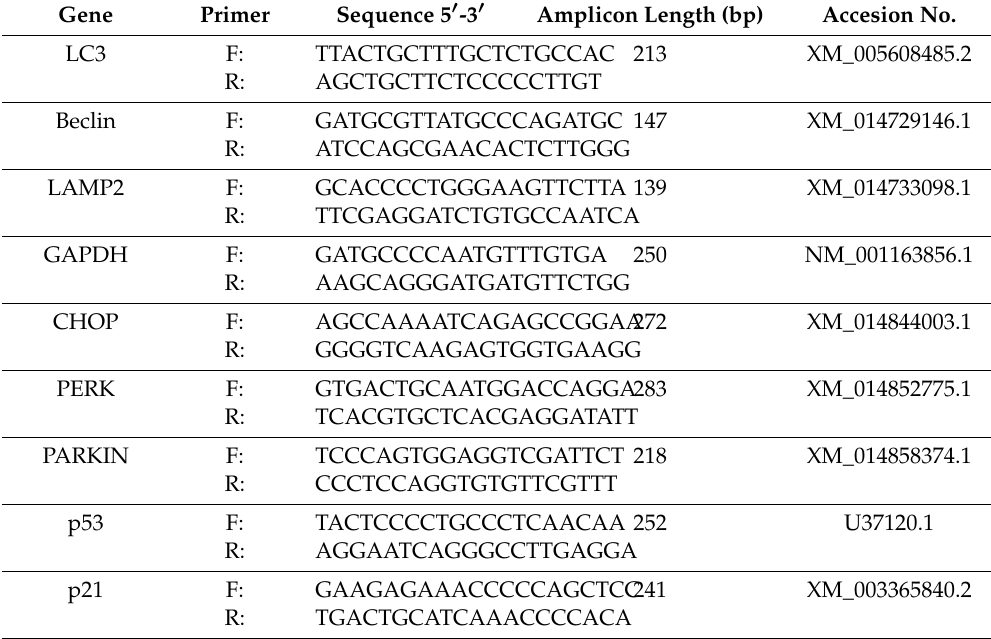
Table 1. Sequences of primers used in qPCR. Sequences, amplicon length and accession numbers of the primer sets. LC3: microtubule associated protein 1 light chain 3 beta (MAP1LC3B); Beclin: beclin 1, autophagy related (BECN1); LAMP2: lysosomal-associated membrane protein 2; GADPH: Glyceraldehyde-3-Phosphate Dehydrogenase; CHOP: DNA damage inducible transcript 3 (DDIT3); PERK: eukaryotic translation initiation factor 2- α kinase 3; PARKIN: parkin ligase; p53: tumor suppressor p53; p21: Cyclin-dependent kinase inhibitor 1A.